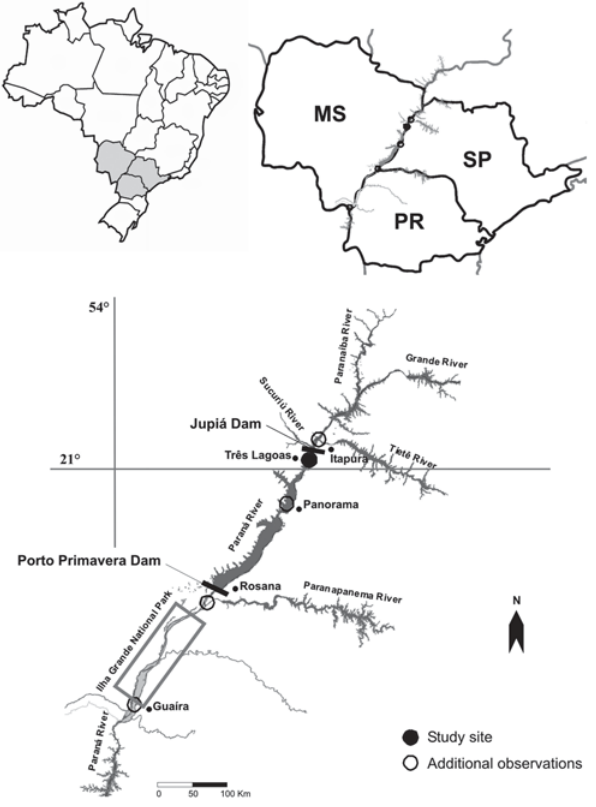
Fig. 1. Illustrative map of the upper Paraná River in the Southeastern Brazil, showing the main rivers in the basin, the study location, and the places where expeditions were conducted to obtain additional